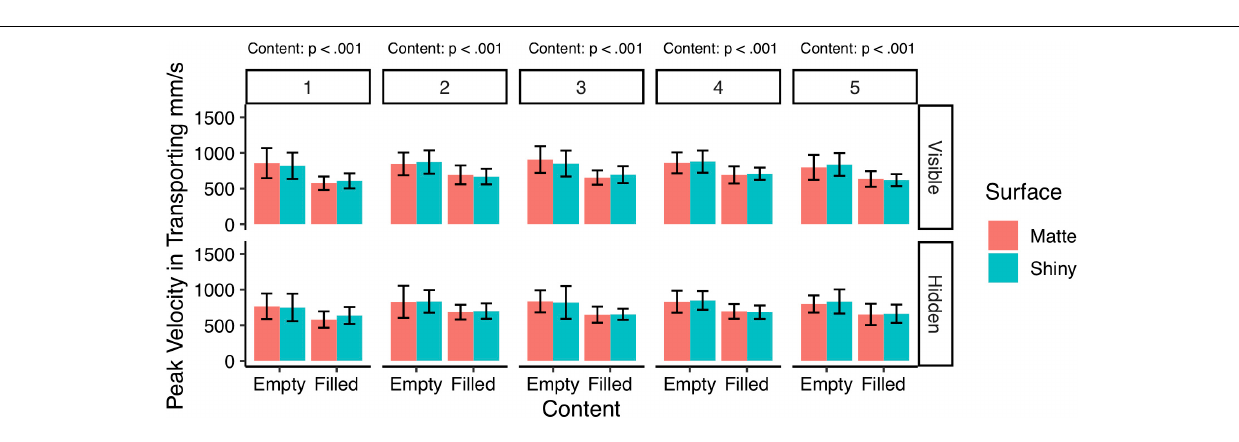
FIGURE 7 | Peak velocity (mm/s) and standard errors when transporting the cups from location A to location B. The graphs show that the filled cups are moved significantly slower than empty cups (all ps < 0.001), whereas no significant effect was found for surface appearance or visibility of the content on peak velocity in